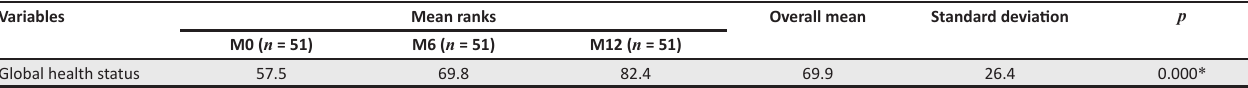
TABLE 2: Global health status across the groups ( n = 153). Variables